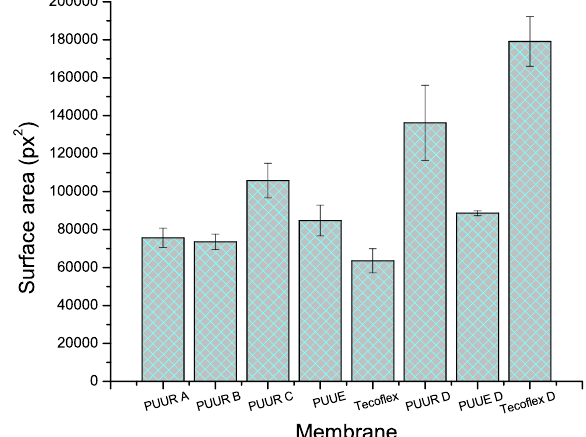
Fig. 7 Cell surface area of live hFBs on electrospun and dense membranes